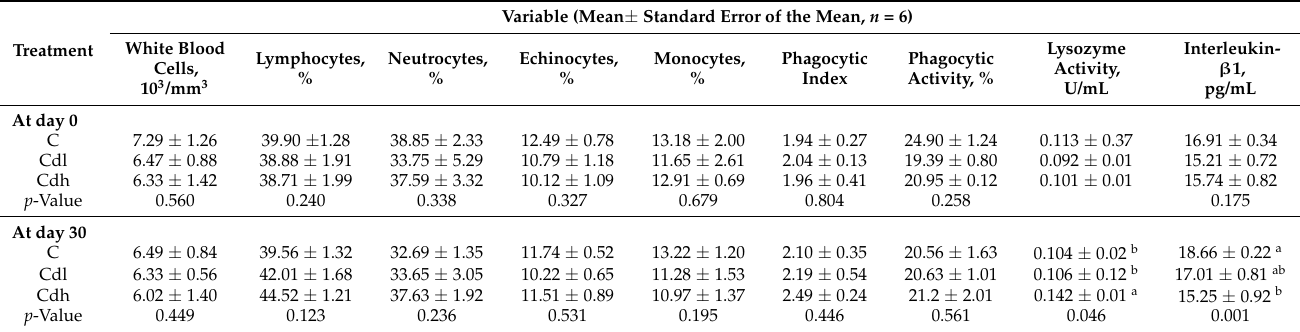
Table 6. Innate immune indicators of rabbits treated with different concentrations of Cleome droserifolia (Forssk.) Del. (Cd) (0: C, Cdl: 1.25 g/kg of DM diet, or Cdh: 2.5 g/kg of DM diet). Variable (Mean ± Standard Error of the Mean, n = 6) White Blood Treatment Lymphocytes, Neutrocytes, Echinocytes, Monocytes, Phagocytic Phagocytic Cells, % % % % Index Activity, % 10 3 /mm 3 At day 0 C